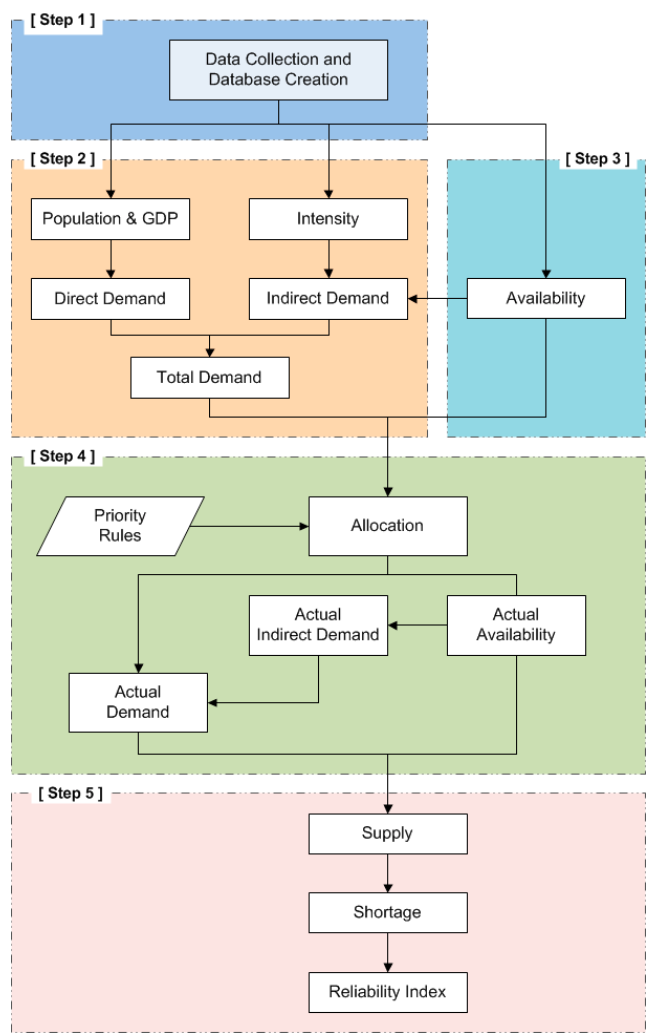
Figure 2. WEFSiM simulation steps.